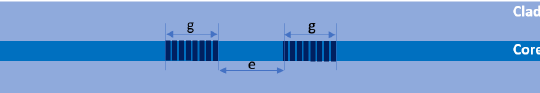
Figure 1. Schematic of grating-based Fabry–Perot.